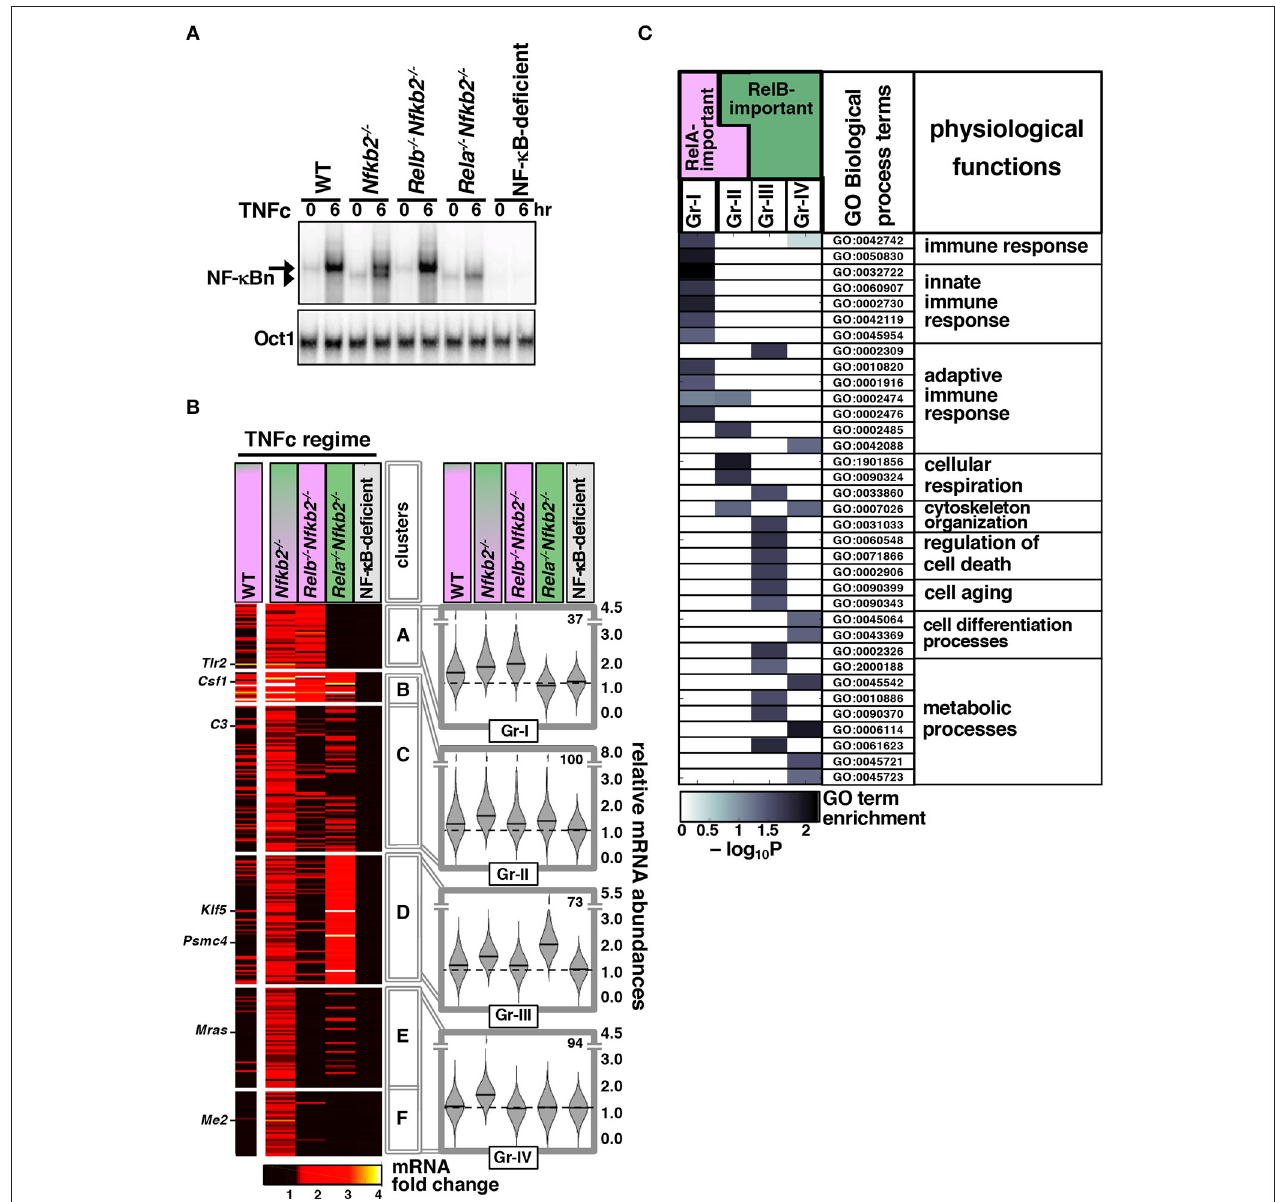
FIGURE 4 | Global analyses reveal distinct gene controls by the TNF-activated RelB:p50 heterodimer. (A) MEFs of the indicated genotypes were treated with TNFc for 6h before being subjected to EMSA. The data represents three independent experiments. (B) In our microarray mRNA analysis, we considered genes with high confidence detection in biological replicates across various knockout MEFs, and at least 1.3 fold increase in the average expression upon 6h of TNFc treatment in Nfkb2 − / − cells, but < 1.3 fold average induction in NF- κ B-deficient cells to arrive onto a list of 304 genes. Heatmap demonstrates TNF-induced fold changes in the expressions of these genes in the indicated knockout cells clustered using the partition around medoids algorithm. A representative data using WT MEFs has been indicated in the left column. The resultant six gene-clusters were arranged into four gene-groups. Representative genes belonging to different groups have been indicated. Right: violin plots show relative frequency distributions of fold change values and corresponding medians for various genotypes as well as the number of members in each gene-group. (C) Functional enrichment of various Gene Ontology for Biological Process terms in the indicated gene-groups was determined by topGO. A subset of highly enriched terms in either of the gene-groups is highlighted. Broad physiological functions associated with these GO terms have been also